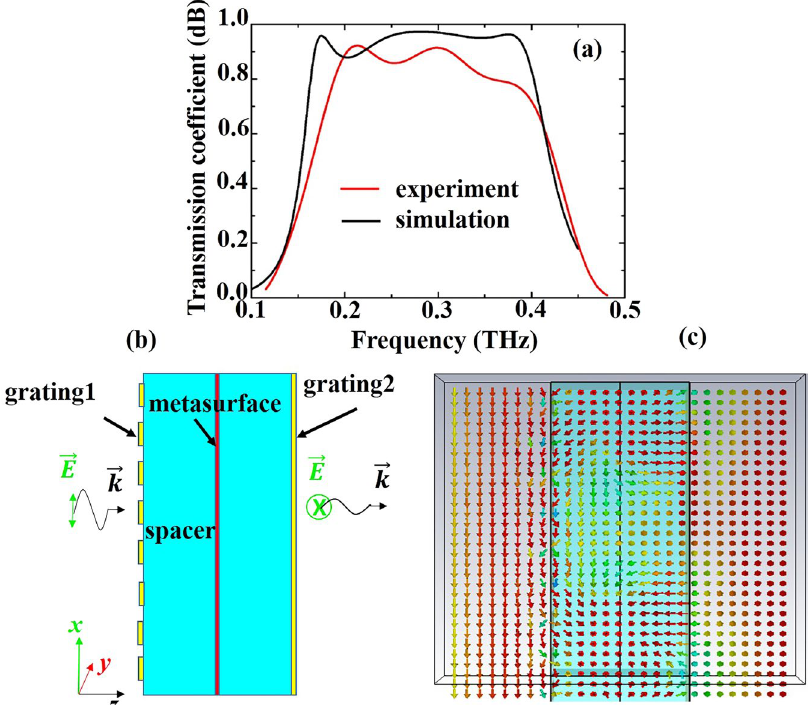
Figure 2. ( a ) Measured and simulated transmission spectra ( t xy ) of cross-polarization. ( b ) Cross section (in the xz -plane) of the proposed polarization converter. ( c ) Simulated electric field distribution in the cross section, which describes the polarization conversion process when the x -polarized EM wave propagates along the z - direction. The arrows denote the direction of the electric